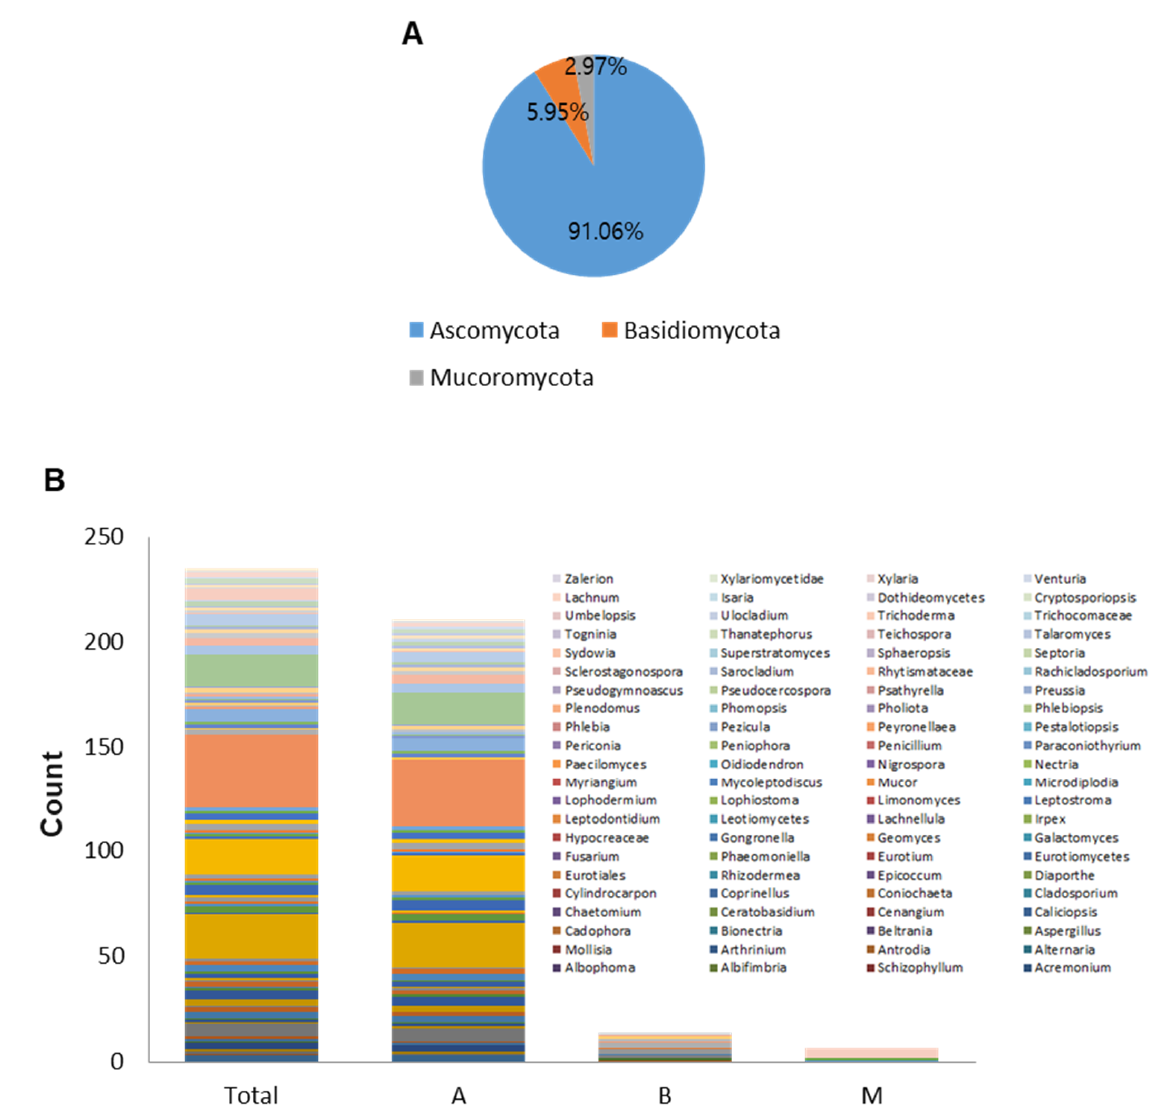
Figure 2. Isolation and identification of fungal endophytes. ( A ) Pie chart showing the percentage of isolated fungal endophytes belonging to the different phyla. ( B ) Bar plot showing the number of fungal species belonging to each of the 88 total genera recovered. Letters A, B and M represent the phyla Ascomycota, Basidiomycota and Mucoromycota, respec- tively.